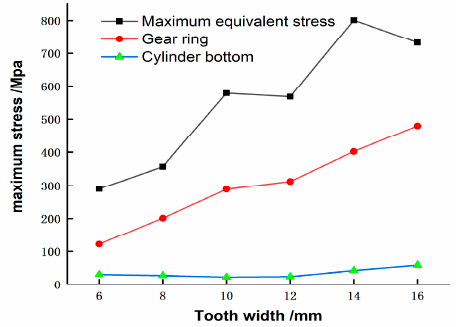
Figure 18. Stress transformation curve with tooth width.